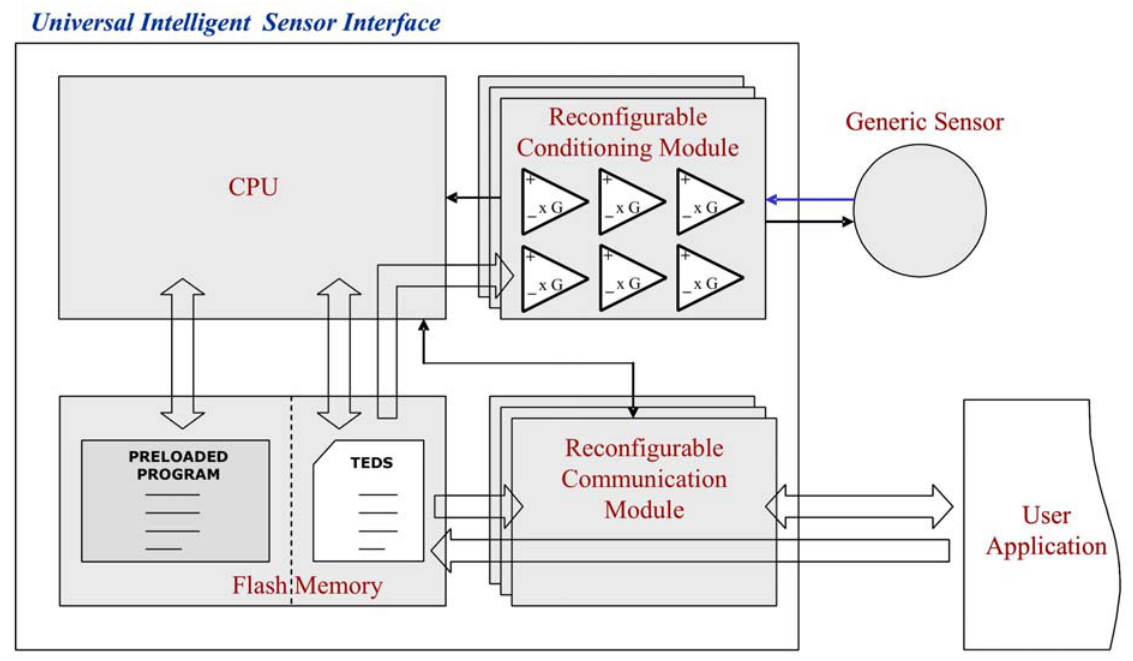
Figure 2. Architecture of